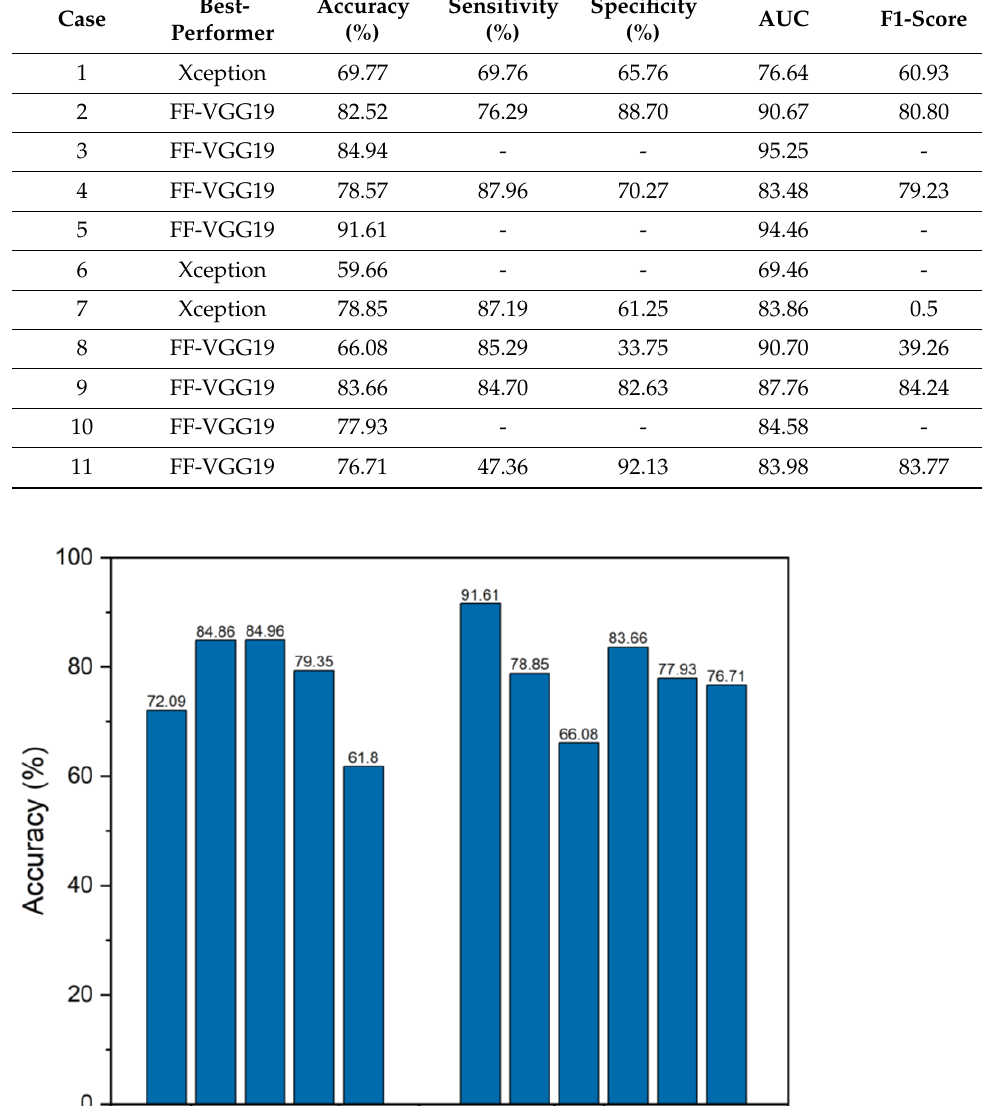
Figure 3. Accuracy improvement of the CNNs when training from scratch on the study ’ s datasets.